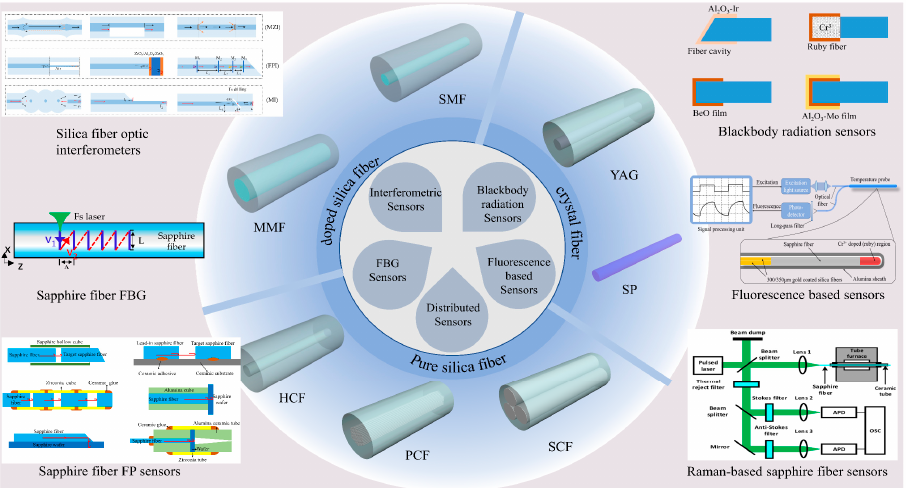
Figure 1. The temperature sensor classification, fiber type, and sensor mechanism from the inside to the outside. SP: sapphire, YAG: Yttrium aluminum garnet, SMF: single-mode fiber, MMF: multi-mode fiber, HCF: hollow-core fiber, PCF: photonic crystal fiber, SSCF: suspended-core fiber.